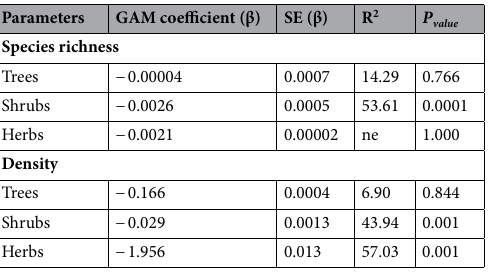
Table 4. Estimated changes in species richness and density of trees, shrubs and herbs with respect to bamboo density in the Singalila National Park. ne Non eligible (as the R 2 value is <